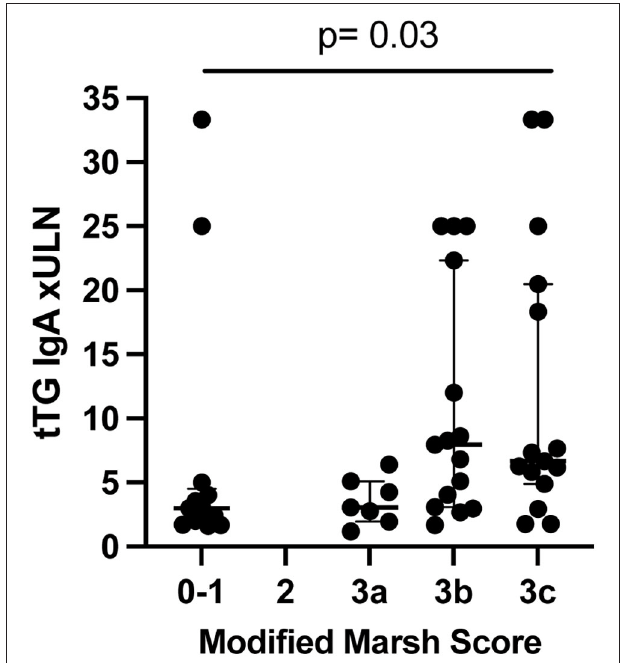
FIGURE 1 | tTG IgA circulating concentration compared to Marsh score in cases ( n = 50) (not controls). P -value from Kruskal-Wallis. Lines show median and quartiles. ULN, upper limit of